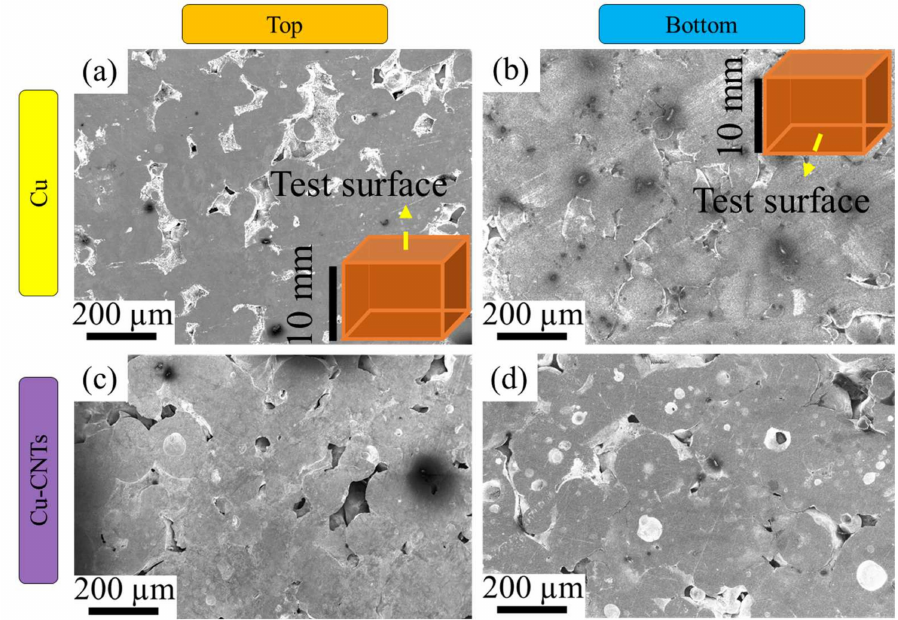
Figure 6. SEM images of LPBF-AM Cu from ( a ) top and ( b ) bottom surfaces; Cu-CNTs from ( c ) top and ( d ) bottom